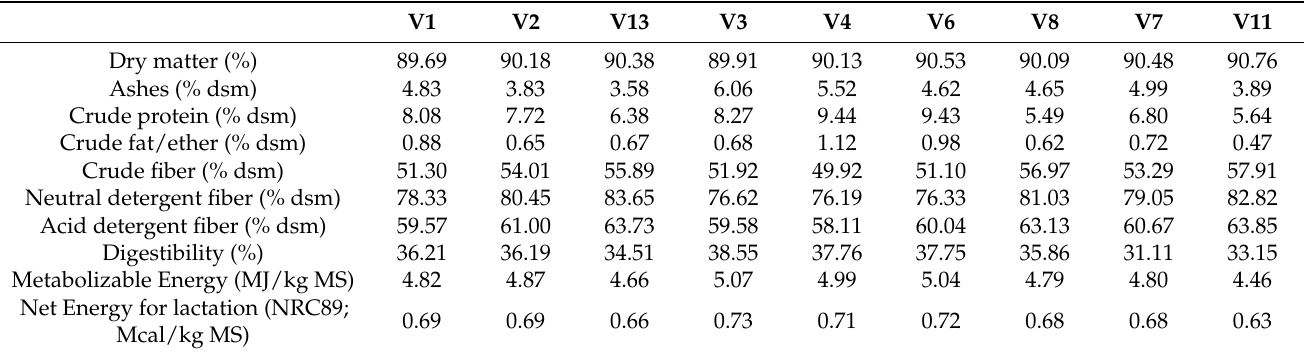
Table 4. Nutrient composition of Camelina sativa straw.